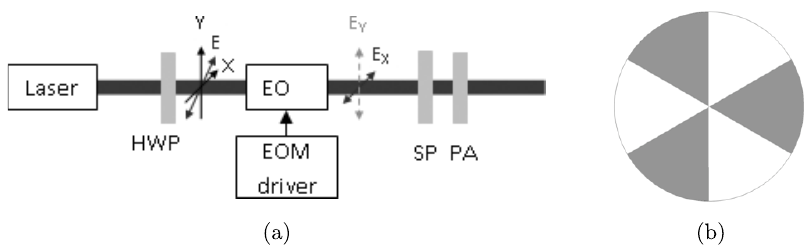
(b) A six-zone spatial polarizer that selectively passes horizontally polarized light (white zones) or vertically polarized light (gray zones). HWP: Half wave plate; SP: spatial polarizer; PA: polarization analyzer.